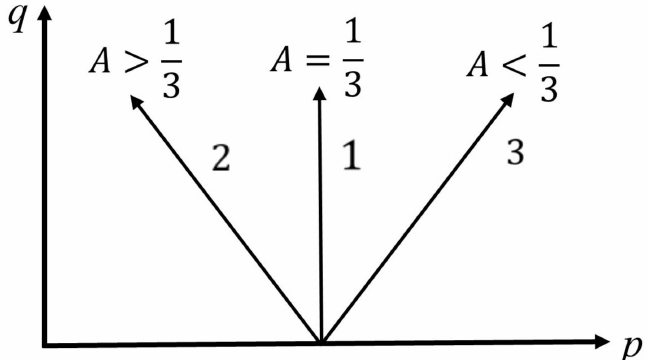
Figure 1. The direction of different A values: (1) A = 1/3 relative to elastic deformation; (2) A > 1/3 relative to compression; (3) A < 1/3 relative to